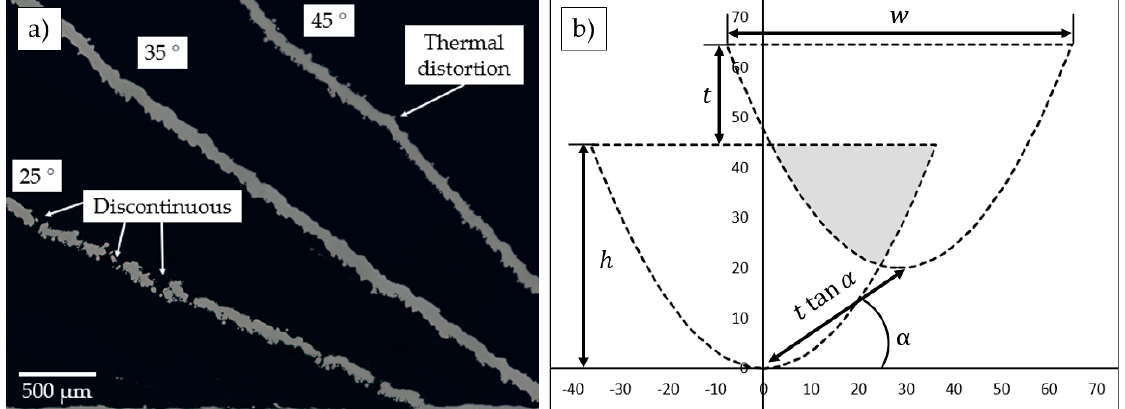
Figure 8. ( a ) OM of walls with different inclined angles; ( b ) schematic represantation of the overlapping beween adjacent tracks during single track manufacturing of inclined objects.